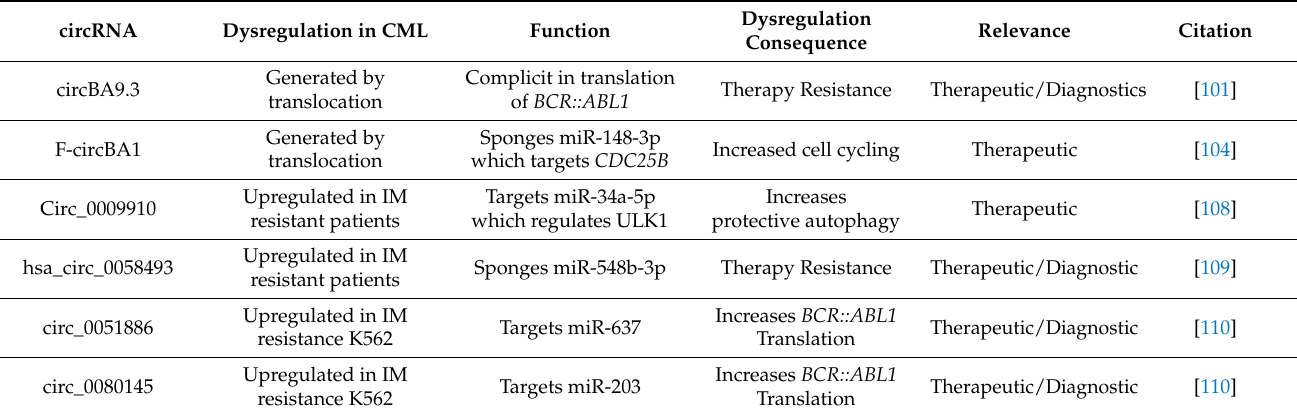
Table 2. Summary of discussed circRNAs dysregulated in